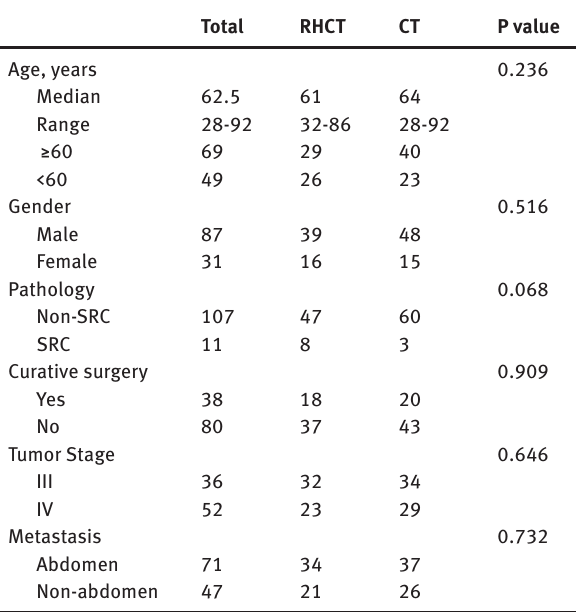
Table 2: Comparisons of treatment response in the two